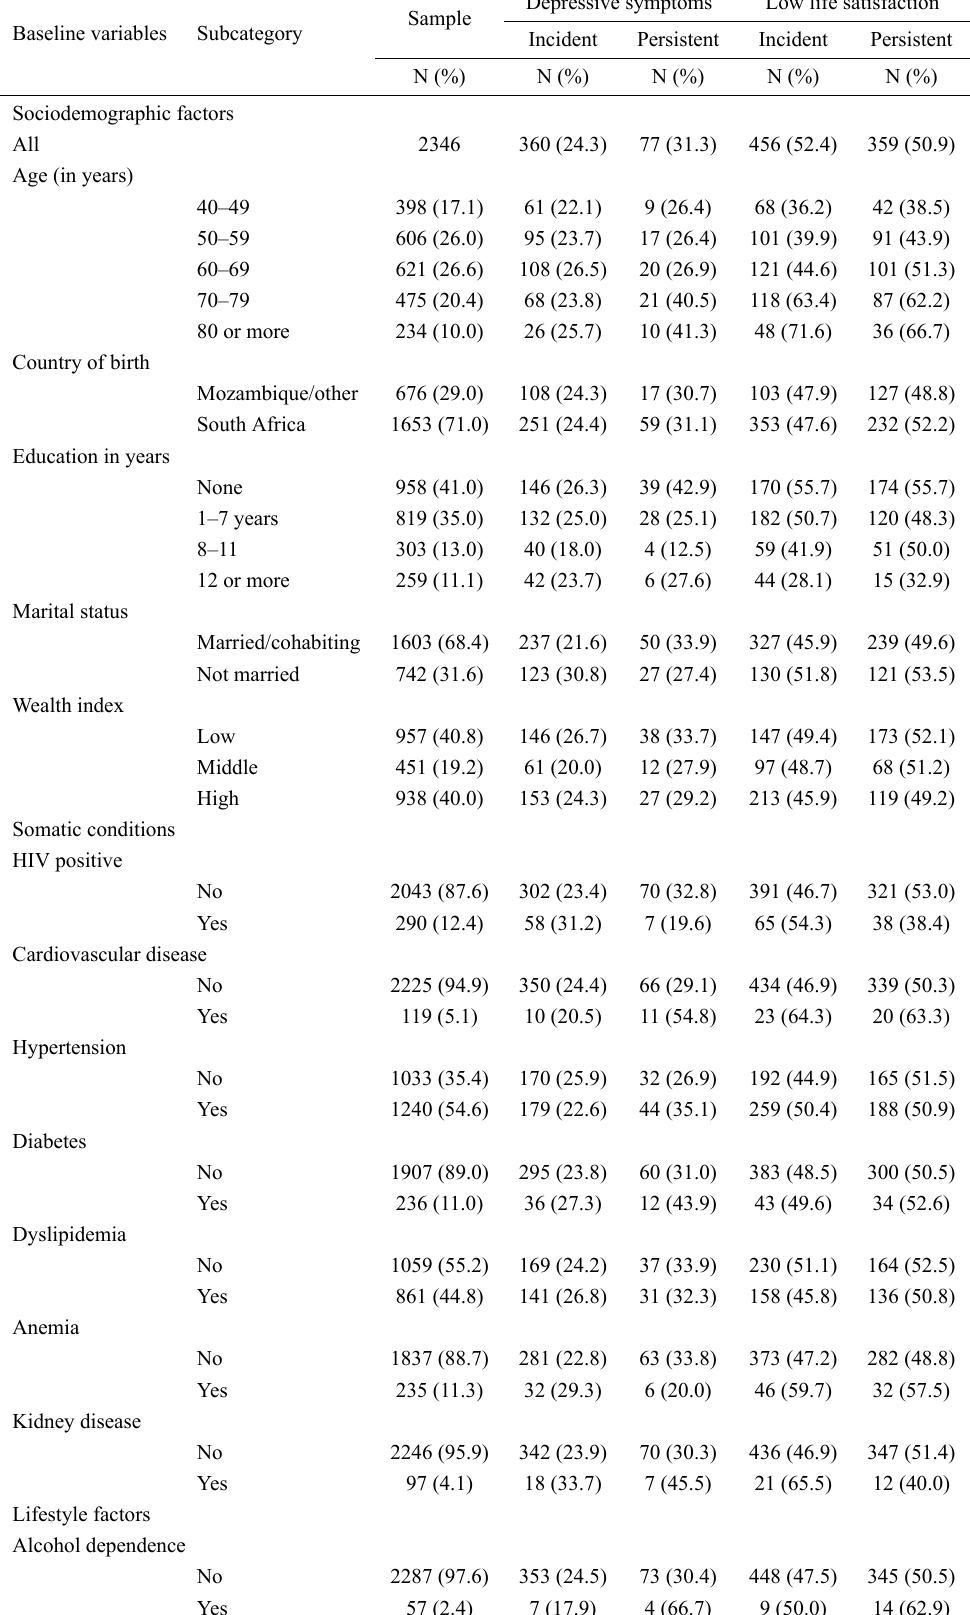
Table 1. Sample characteristics of men 40 years and older, Agincourt, South Africa,